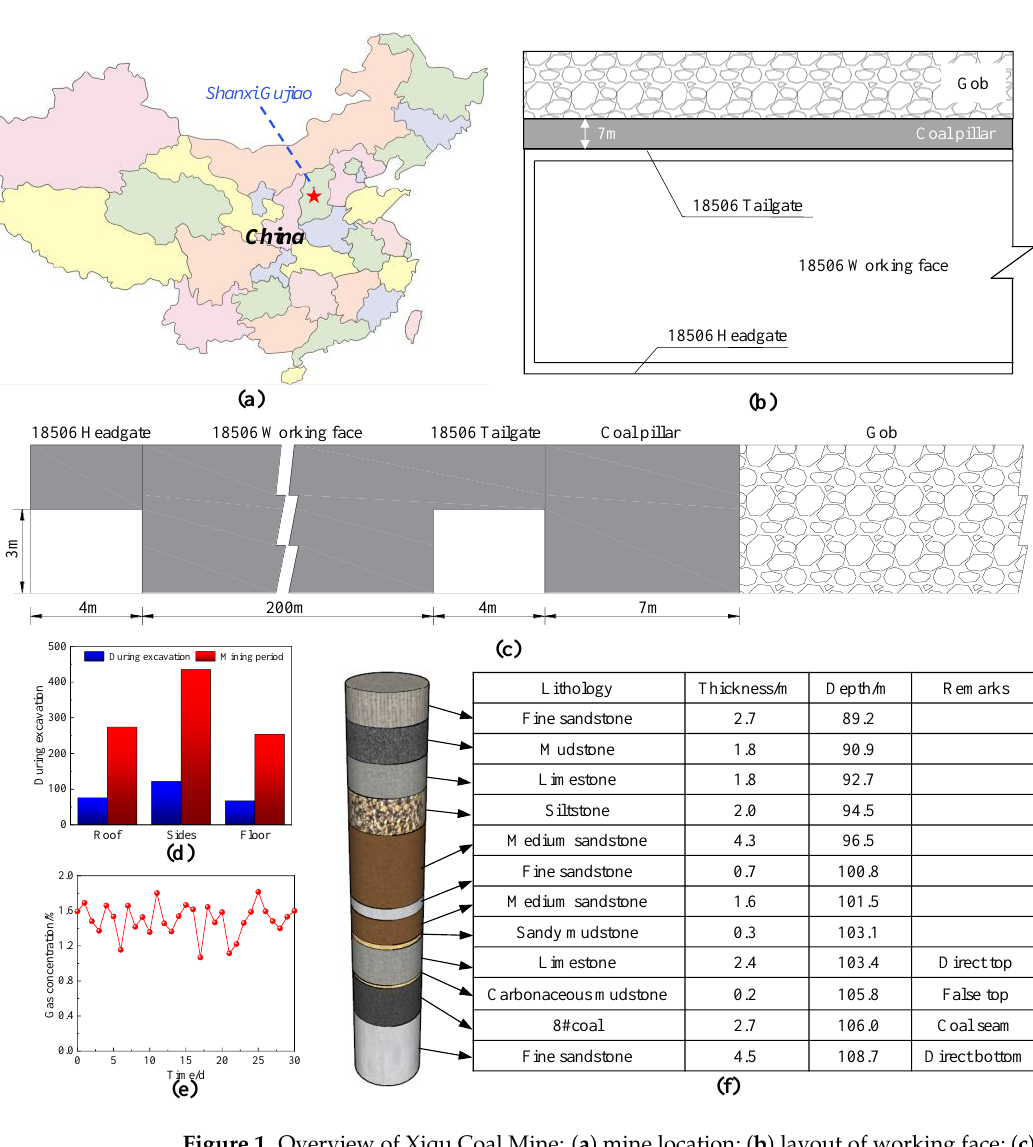
Figure 1. Overview of Xiqu Coal Mine: ( a ) mine location; ( b ) layout of working face; ( c ) section view; ( d ) roadway deformation; ( e ) gas concentration; ( f ) section view.